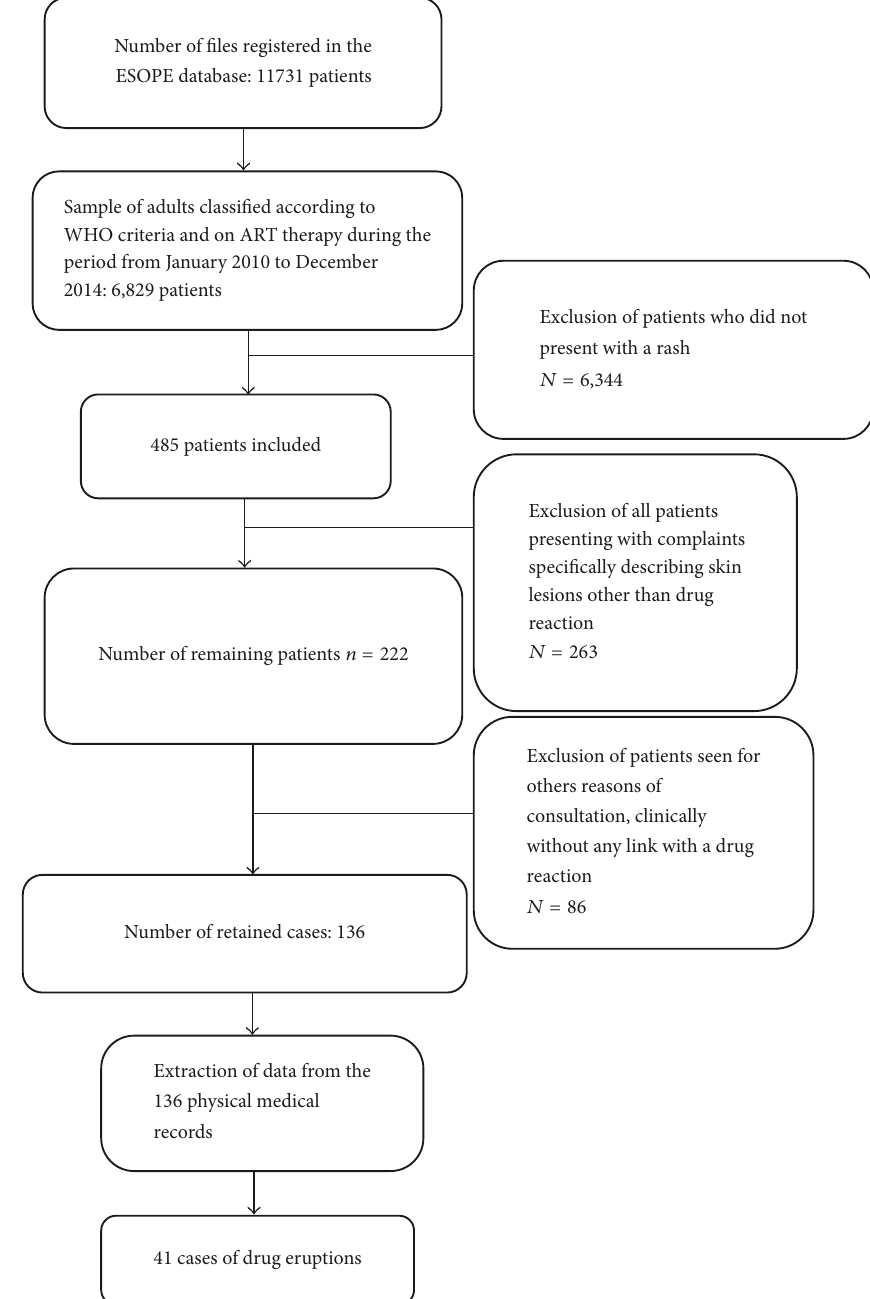
Figure 1: Algorithm describing the sampling